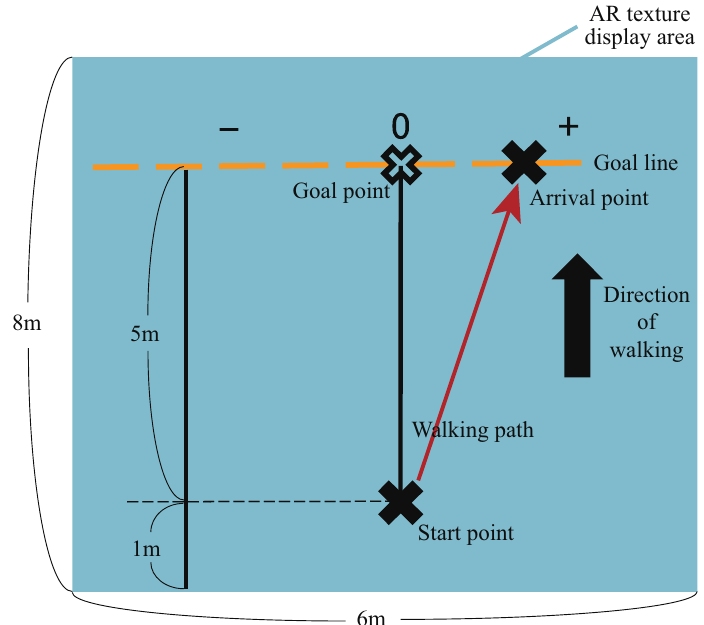
Figure 22. The experimental environment when displaying the AR moving stripes